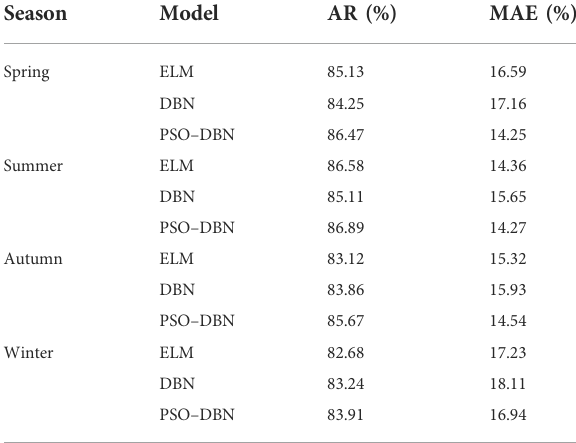
TABLE 1 Comparison of prediction results in four seasons.